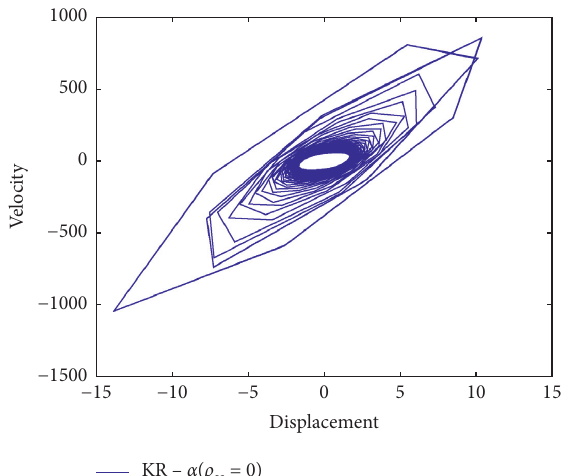
Figure 21: Phase portrait of the hardening spring calculated using the KR- α method ( ρ